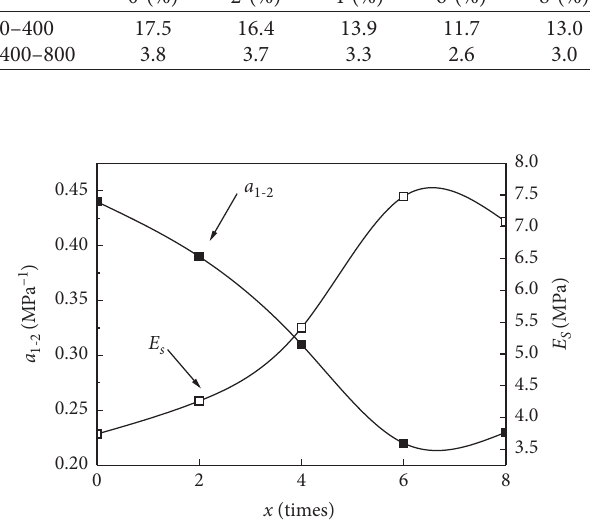
Figure 2: Relation between a